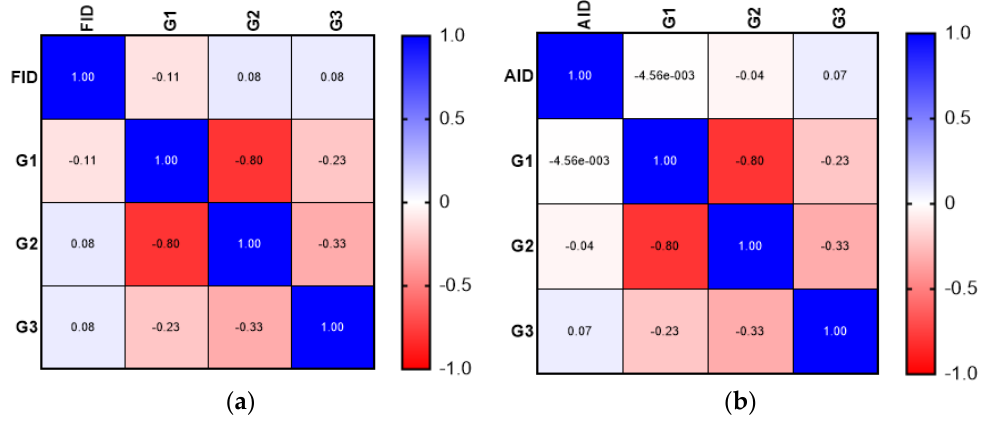
Figure 3. Comparison between FID and AID: ( a ) correlation matrix for FID and tumor grade; ( b ) correlation matrix for AID and tumor grade.